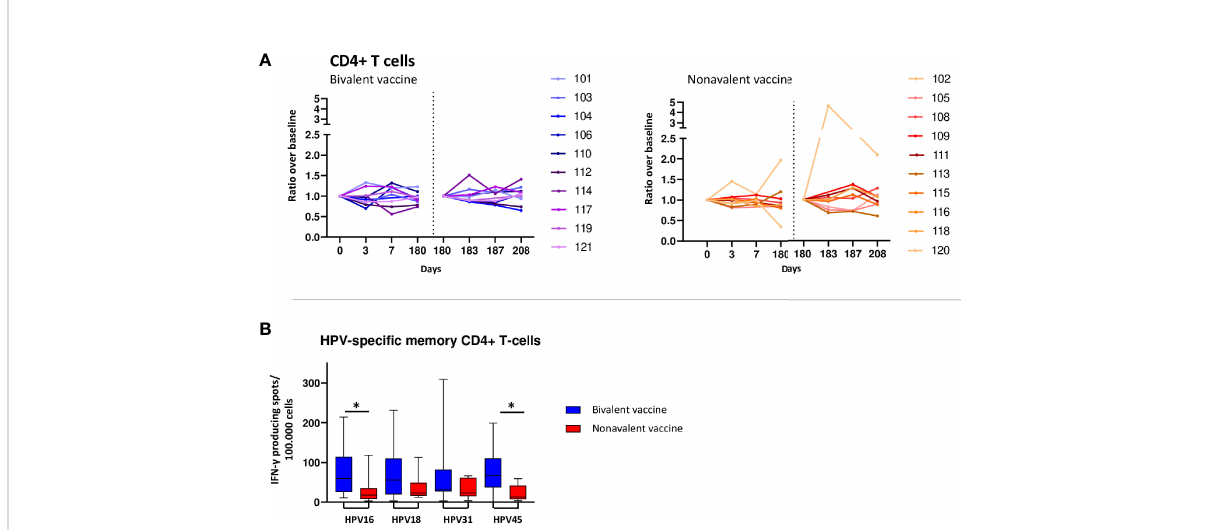
FIGURE 3 T-cell responses. (A) Kinetics of circulating CD4+ T-cells upon bivalent (purple-blue) and nonavalent (orange-red) vaccination at day 0, 3, 7, 180, 183, 187 and 208 post vaccinations presented as ratio in cell numbers compared to baseline cell numbers (cells/ m L blood) depicted per participant. Participant identi fi cation by color is indicated on the right. At day 180, participants received the third HPV vaccination. therefore, this day served as a new ‘ baseline ’ moment to normalize the cell numbers from day 181 and 183, 1 and 3 days post third vaccination respectively. The dotted vertical line split the results post 1 st and 3th vaccination. (B) Numbers of HPV16/18/31/45-type speci fi c memory CD4+ T cells producing IFN- g at day 208, 28 days post third vaccination. PBMCs have been stimulated with HPV-type speci fi c virus like particles (VLPs) for 4 days after which IFN-y producing cells have been enumerated by ELISPOT assay per 100.000 PBMCs. *indicates signi fi cant difference between the cohorts